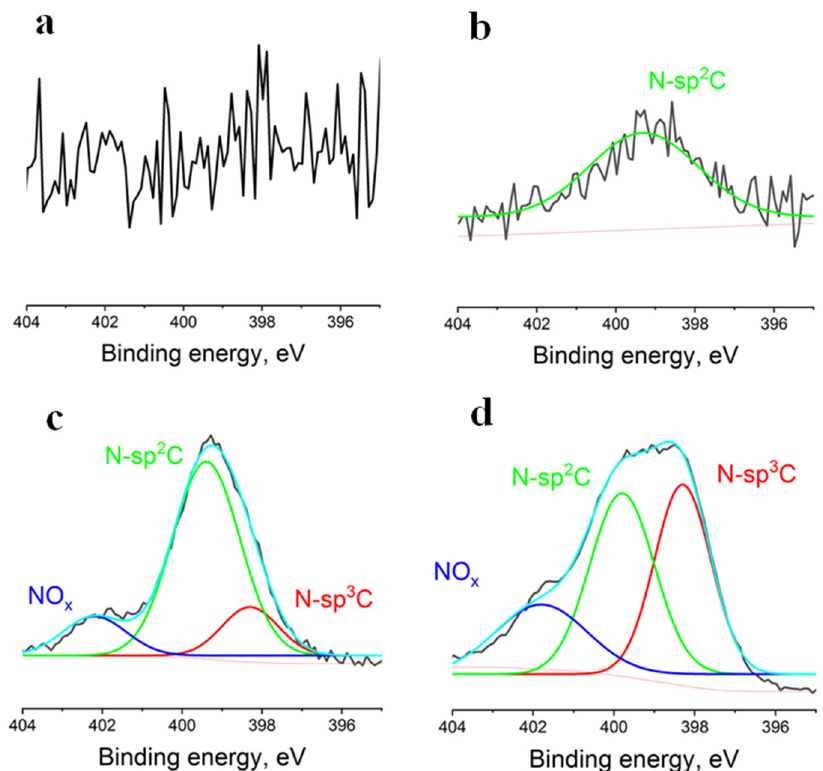
Figure 5. N1s spectra of the control and modified scaffolds. ( a )—spectrum of the control sample, ( b – d )—spectra of the samples coated under 5 × 10 − 3 , 5 × 10 − 2 and 5 × 10 − 1 Pa nitrogen pressure, respectively. Table 2. Water contact angles of the fabricated